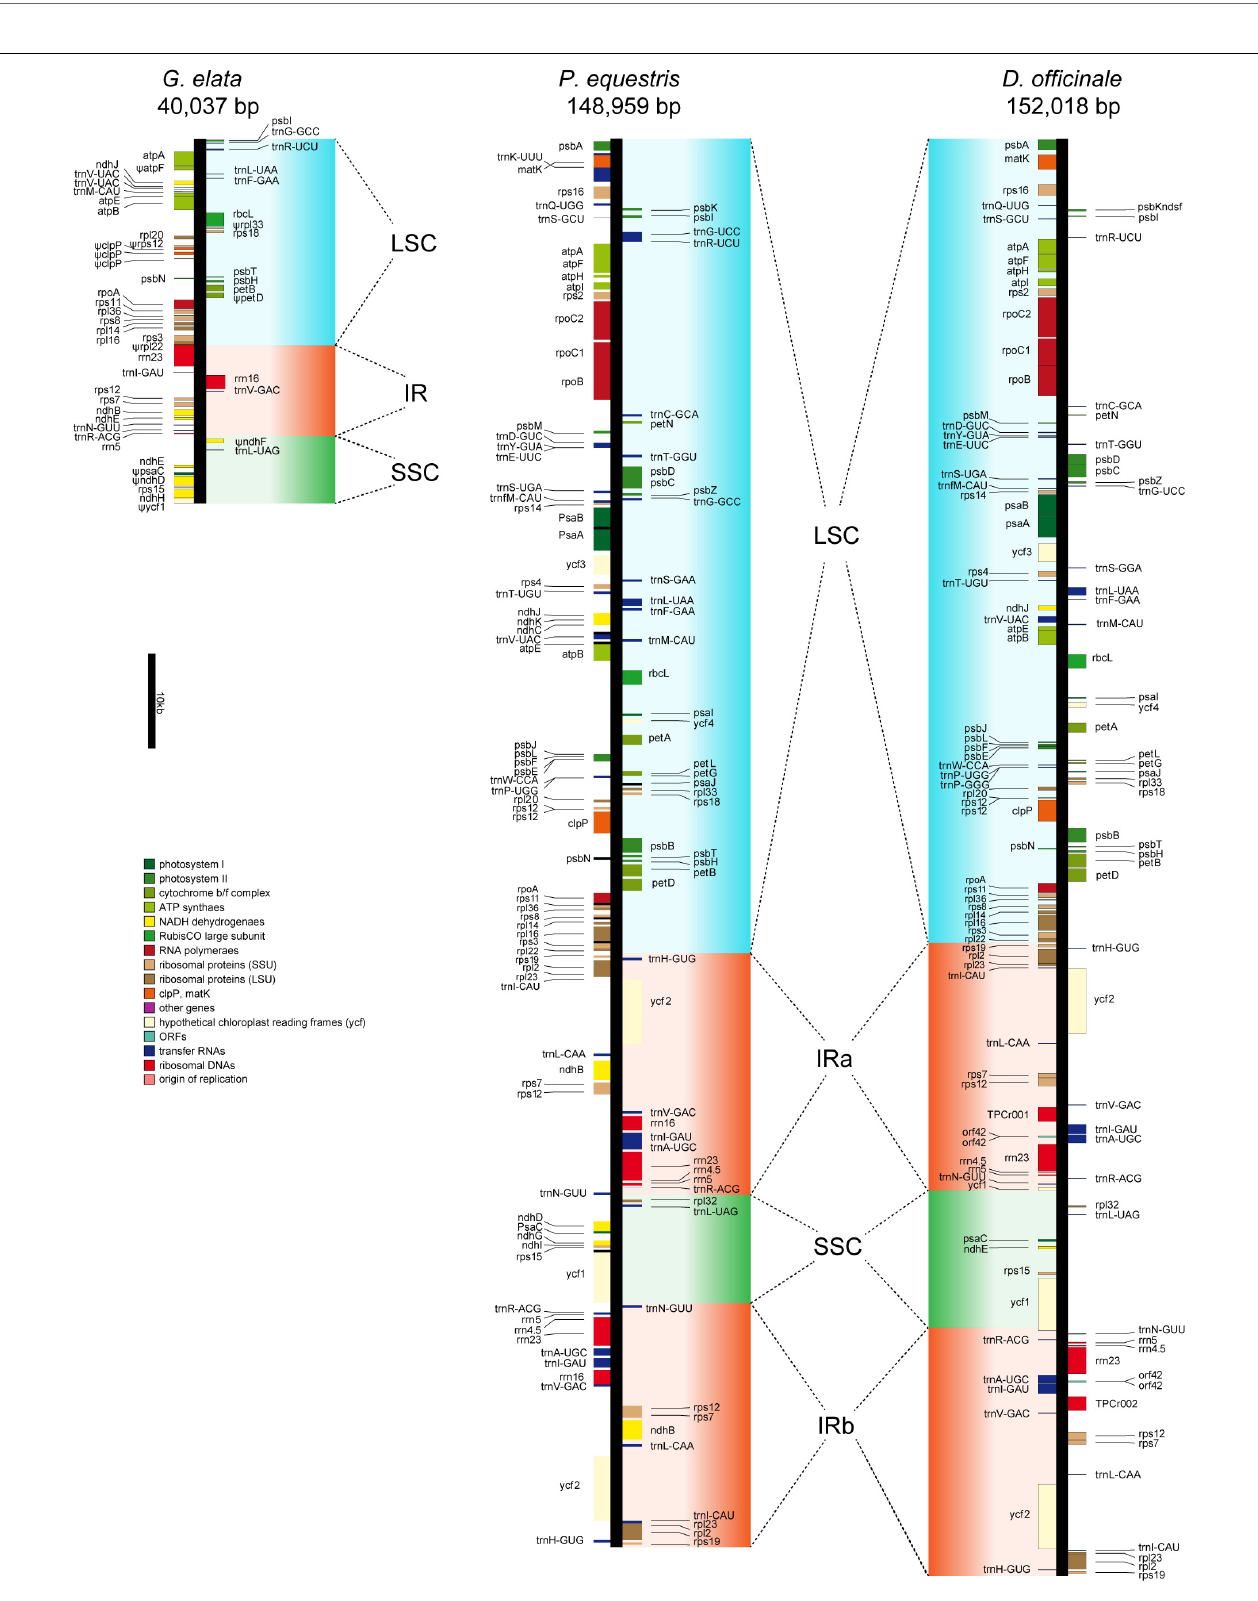
FIGURE 2 | Plastid map of three orchid plants. The plastid of G. elata shows significant degradation comparing with P. equestris and D. officinale . (cid:57) indicates the pseudogenes.